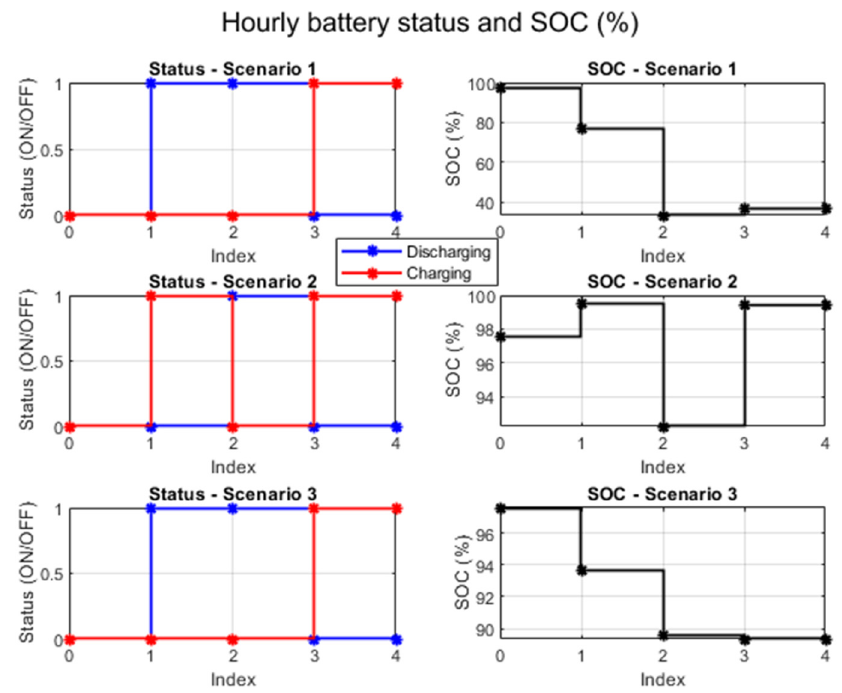
Figure 3. Hourly battery status (ON or OFF) and battery SOC for the three scenarios. For all scenarios, the battery is initially charged at 98%. As expected, scenario 1 indicates a significant drop in battery SOC , whereas in scenario 2, the battery undergoes some instances of charging. Scenario 3 also shows discharge; however, at a significantly lower rate than that of scenario 1.